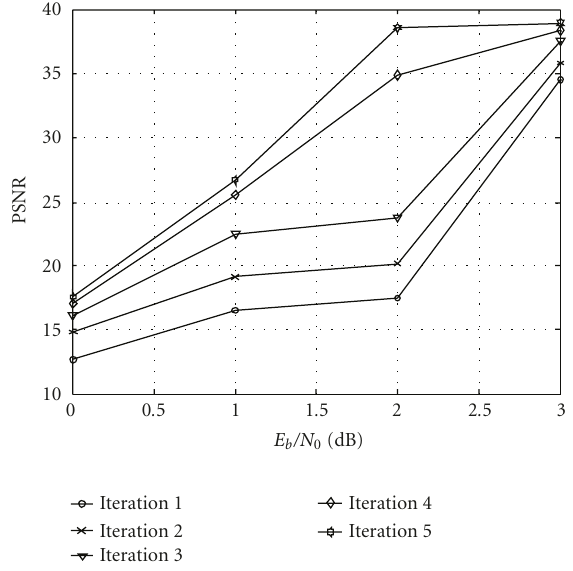
Figure 12: Decoded image quality (in PSNR) of typical turbo code over AWGN channel.